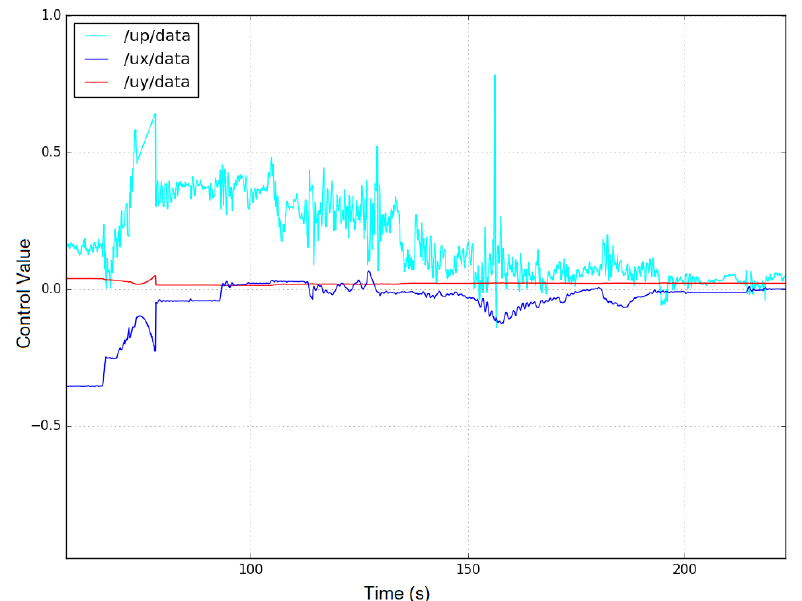
Figure 17. 3-axis control signals for the BlueROV follower-2 robot. (The blue, red, and light blue line represent the control signal on the x-axis and y-axis and the corresponding angle control signal, re- spectively).